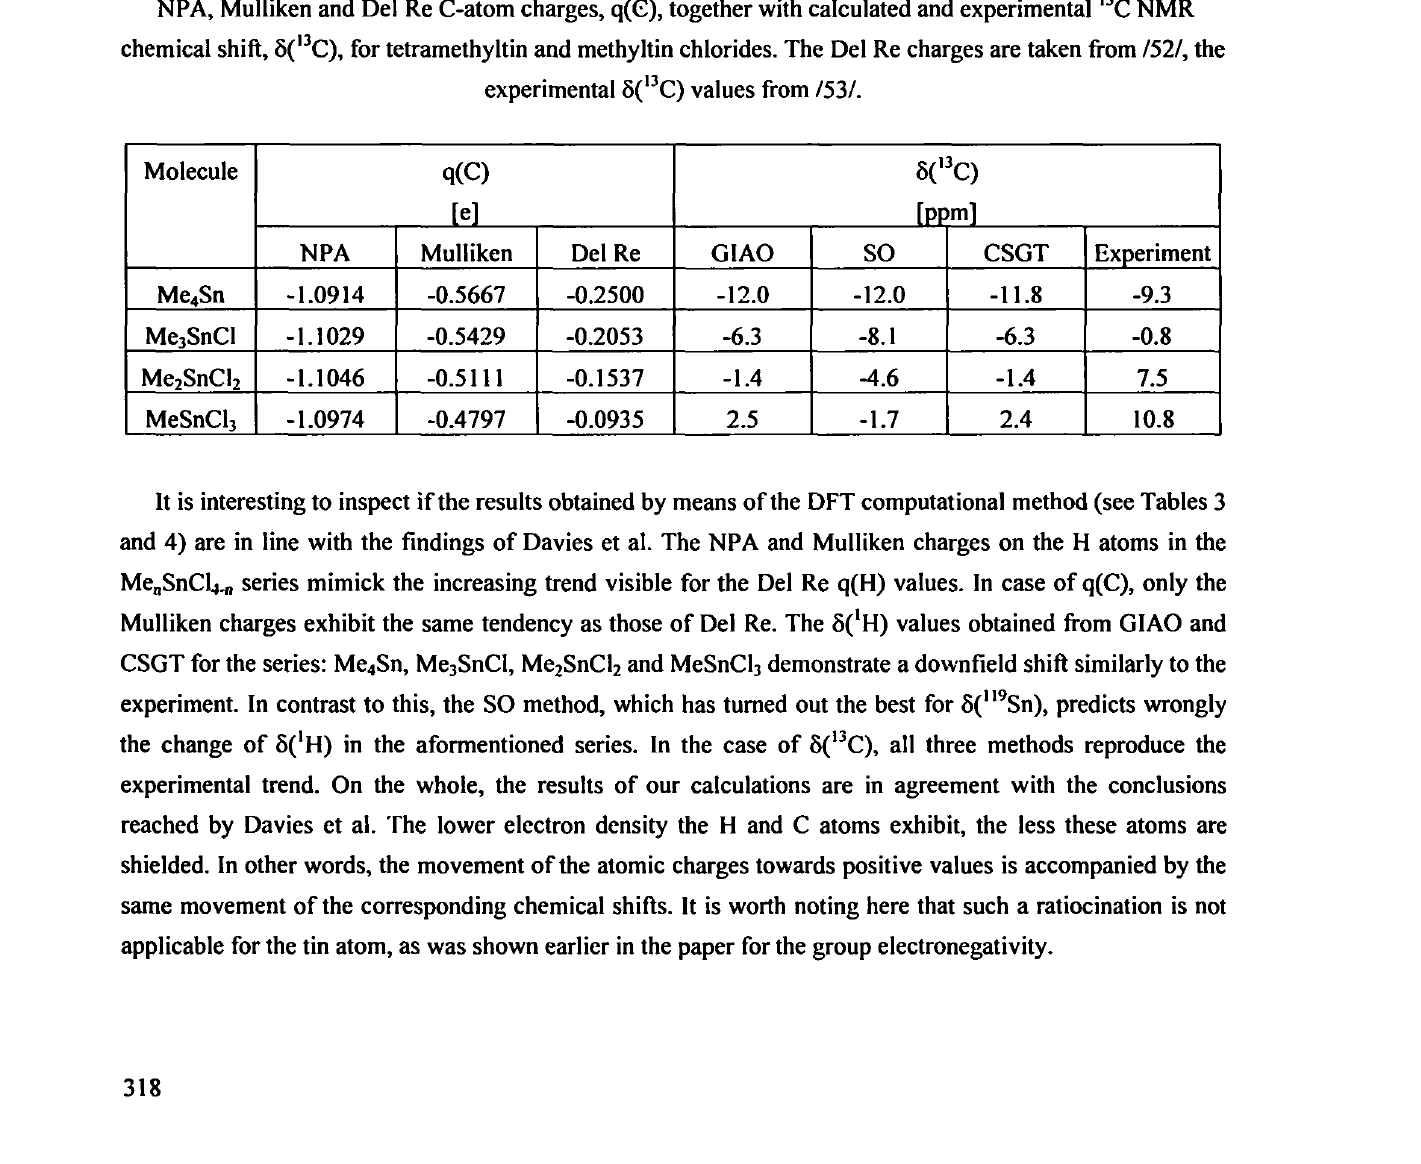
NPA, Mulliken and Del Re C-atom charges, q(G), together with calculated and experimental 13 C NMR chemical shift, δ(' 3 €), for tetramethyltin and methyltin chlorides. The Del Re charges are taken from 7527, the experimental o( 13 C) values from